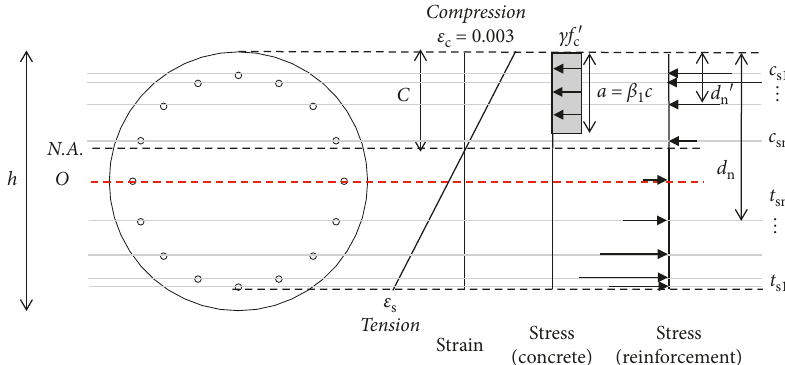
Figure 5: The strain and stress distributions of an RC section based on the strain compatibility